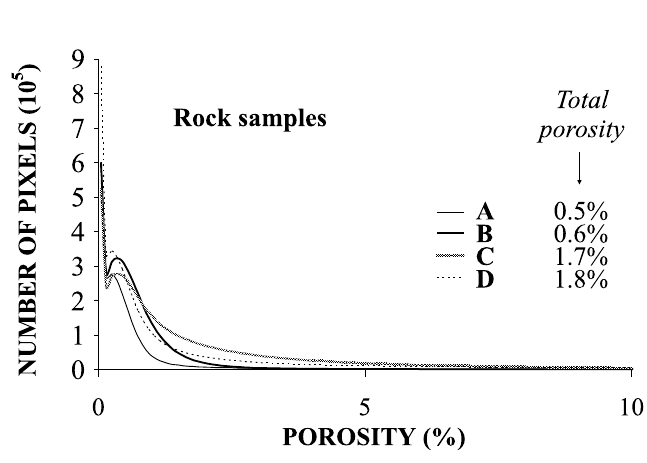
Fig. 6 – Histogram of total rock porosity (%) calculated for samples A, B, C and D. See text for